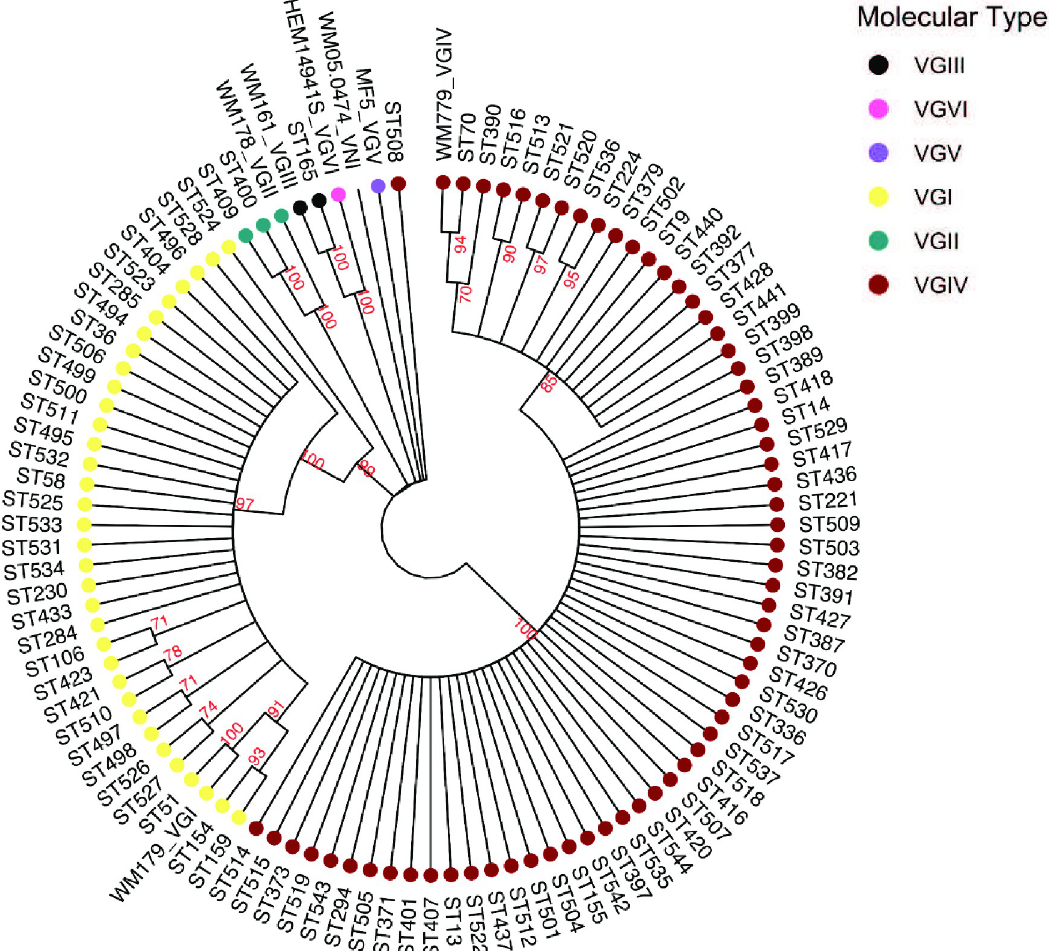
Fig 1. Neighbour joining phylogenetic tree based on multilocus sequence typing data showing clustering of the molecular types for 99 different sequence types (STs) from 146 South African clinical Cryptococcus gattii isolates. Cryptococcus neoformans strain WM 05.474, molecular type VNI serves as the outgroup. A standard strain for each molecular type was also included. Bootstrap analysis was performed with 100 bootstrap replicates. Bootstrap values are shown next to the branches.